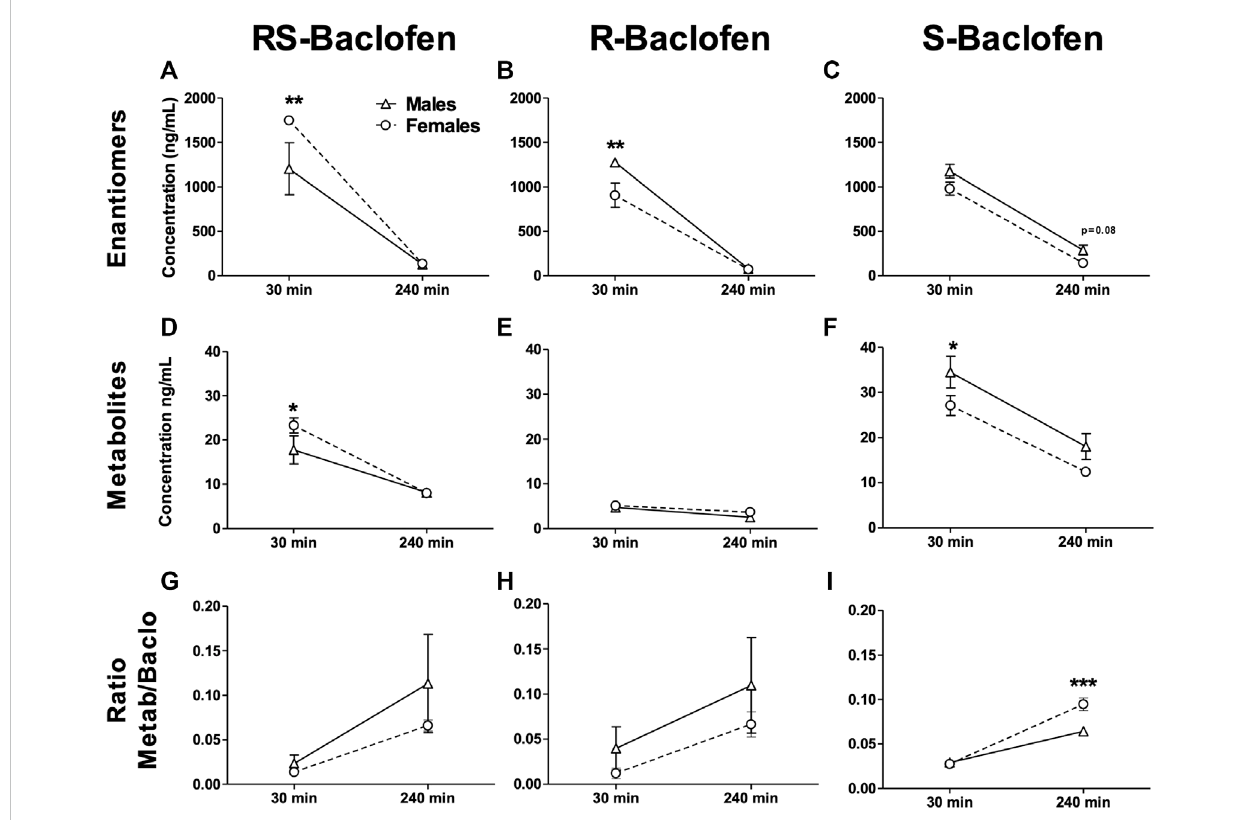
FIGURE 4 Metabolismofbaclofen ’ senantiomersinnaïvemalesandfemalerats.The3Baclofenformswerei.p.injectedrandomlyatthedoseof1.5 mg/kgand blood was collected 30 and 240 min after the administration. HPLC analysis was used to analyze the concentration of the enantiomers (A – C) , and the metabolite 3-(4-Chlorophenyl)-4-hydroxybutyric acid (D – F) . The ratio metabolite over enantiomers concentrations was then calculated (G – I) . Results are expressed as Mean ± SEM of blood concentrations in ng/mL. For (A,D,G) males n = 5; females n = 10. For (B,E,H) males n = 8; females n = 9. For (C,F,I) males n = 6; females n = 9. For clarity purpose we did not depict the signi fi cant differences we found for all the comparisons between the 2 timepoints within each sex group. * p < 0.05, ** p < 0.01 and *** p <